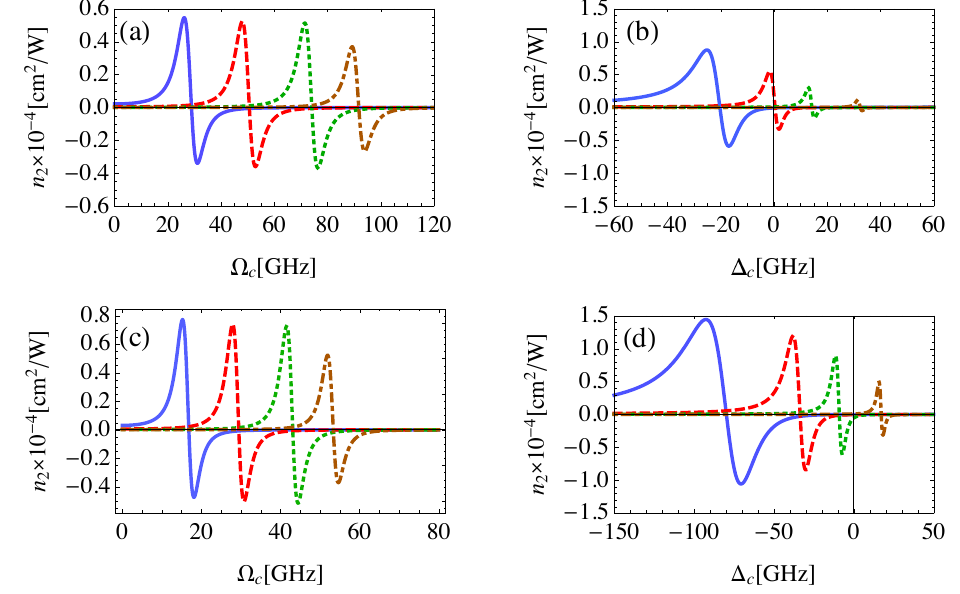
Figure 7. The self-Kerr nonlinear index of refraction for the probe field in the MNP-GND-QD hybrid system of R M = 15 nm ( a , b ), R M = 18 nm ( c , d ), R GM = 26 nm, θ M = 0.5 rad, θ G = 1 rad, excited with control field of ( a , c ): ∆ c = 0, ( b , d ): Ω c = 50 GHz and probe field of detuning ∆ p = 10 GHz (solid), ∆ ∆ ∆ p = 18 GHz (dashed), p = 26 GHz (dotted), and p = 40 GHz